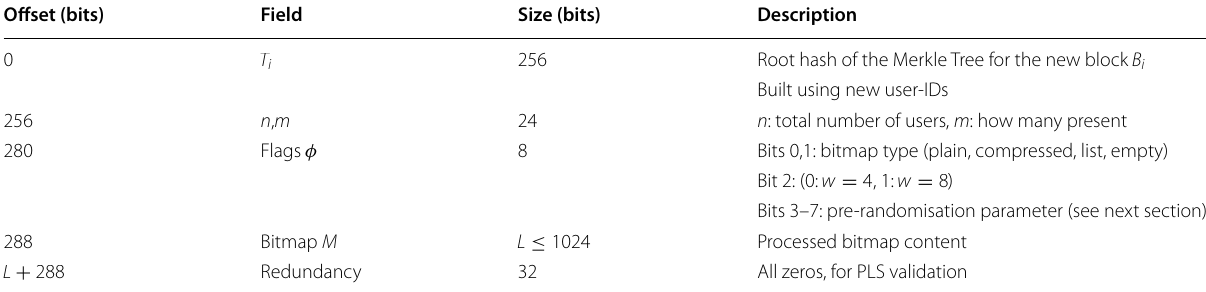
Table 4 Structure of the proposed block root-of-trust J